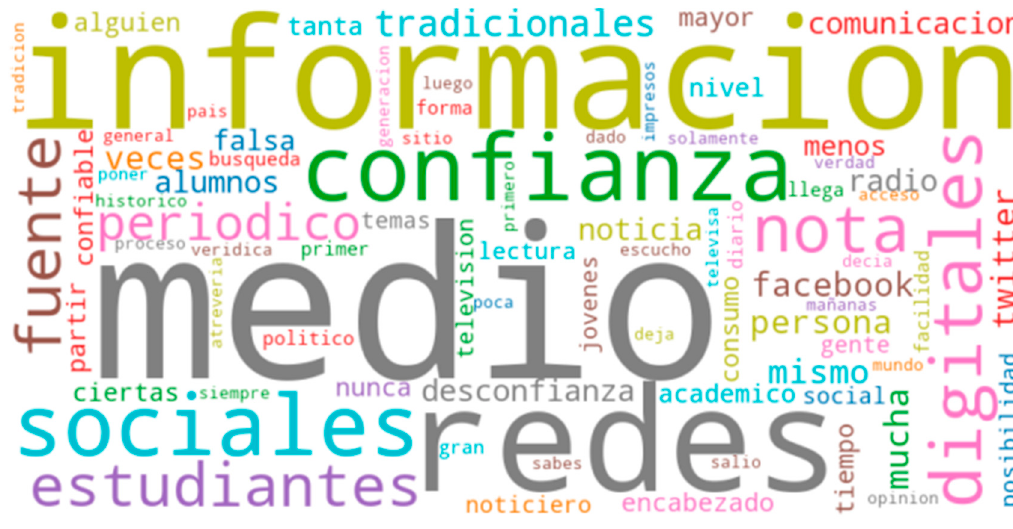
Figure 1. Frequency of words about trust in the media.